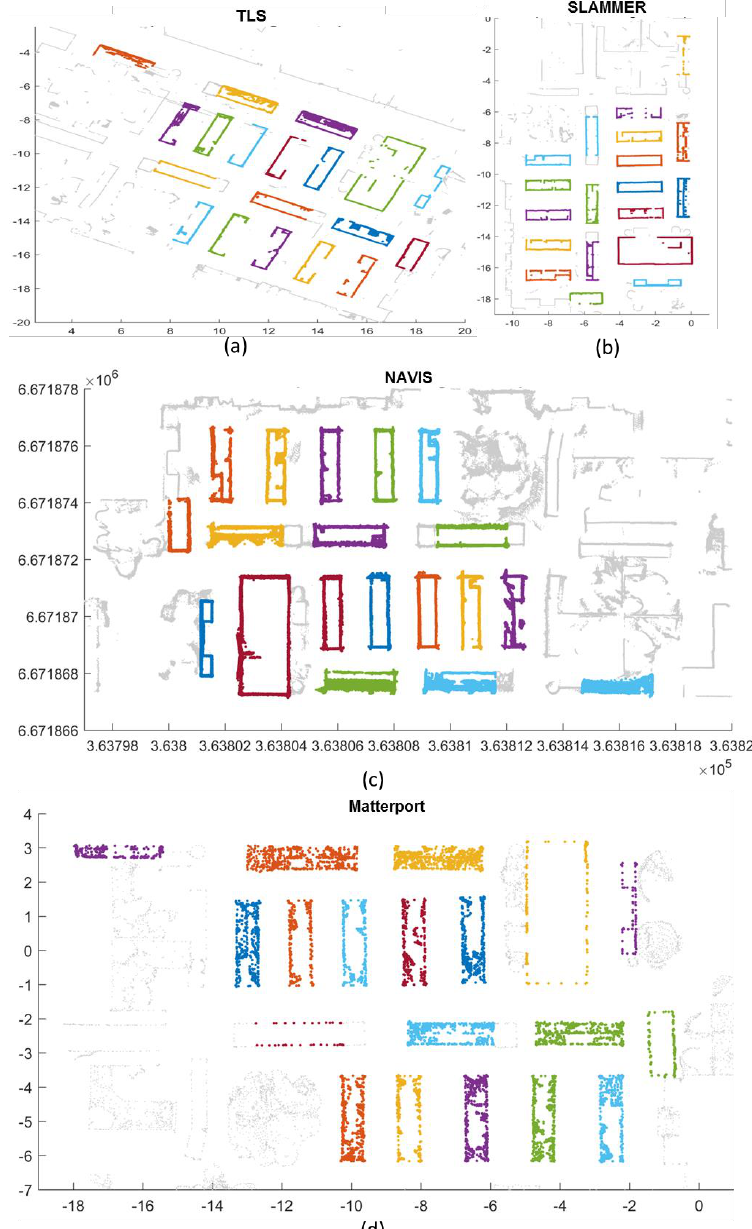
Figure 11. Segmentation results of mapping data from ( a ) TLS reference, ( b ) SLAMMER ( c ) NAVIS and ( d ) Matterport in local coordinate.